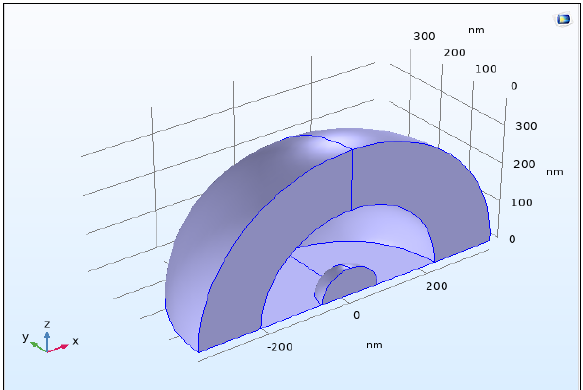
Figure 1. Model geometry of uranium nanoparticle of 40 nm size.